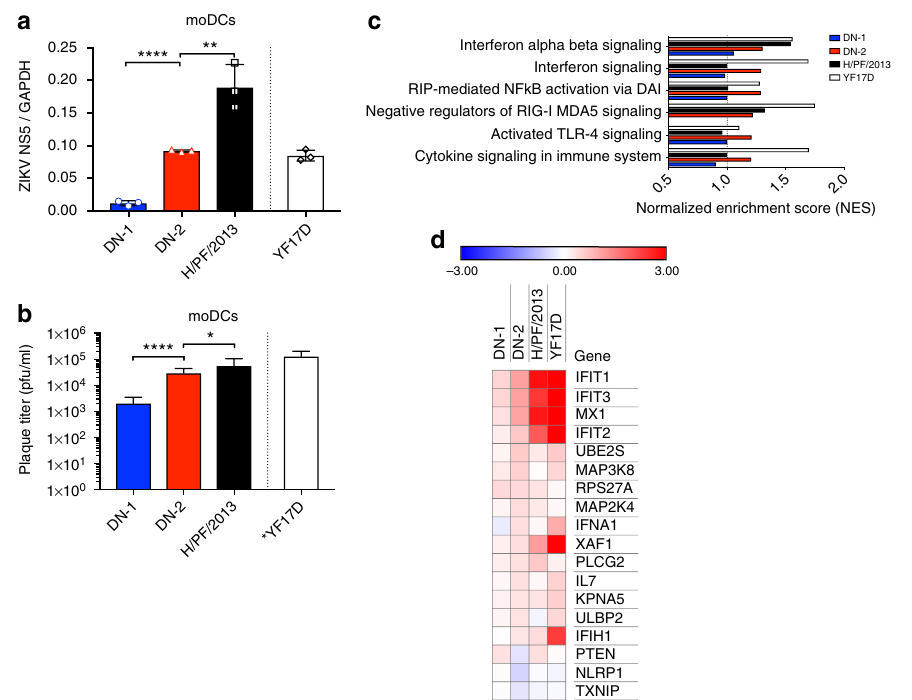
Fig. 4 Ef fi cient replication and immune gene activation in monocyte-derived dendritic cells (moDCs). Viral replication in moDCs at 24 h post infection as determined by a qPCR ( n = 3, representative plot of two experiments) and b plaque assay ( n = 6) on Vero (results of two experiments combined, YF17D plaque assay was performed on BHK-21). c , d Microarray was performed on infected moDCs ( n = 3) after 24 h post infection and analysis was done in comparison to uninfected cells ( n = 3). c GSEA analysis of the most enriched signaling pathways in DN-2 compared to DN-1, H/PF/2013, and YF17D after 24 h post infection in moDCs. Normalized enrichment scores (NES) were computed by GSEA ( n = 3). d Heat map of differentially expressed immune- related genes. Values represented as log 2 (fold change) compared to uninfected cells. Error bars represent s.d. * p < 0.05, ** p < 0.01, *** p < 0.001, **** p < 0.0001 in unpaired t test. n.s. not signi fi